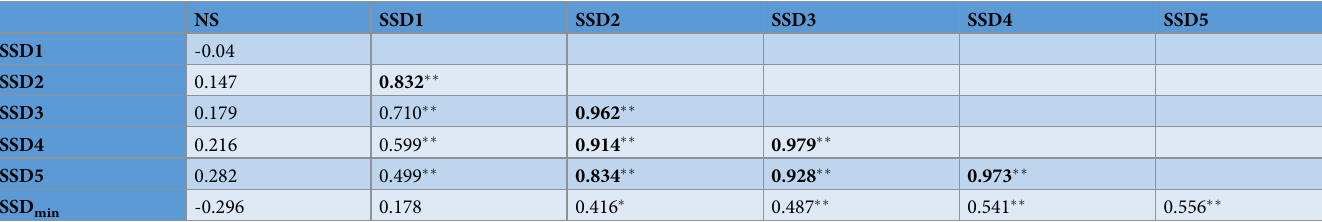
Table 2. Correlation matrix between initial predictors used in discriminant function analysis to sex discrimination. NS SSD1